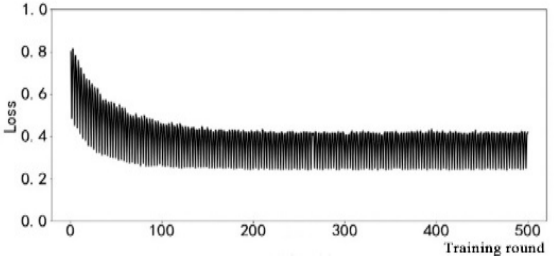
Figure 14. Expert-driven learning with a factor of 1/3.